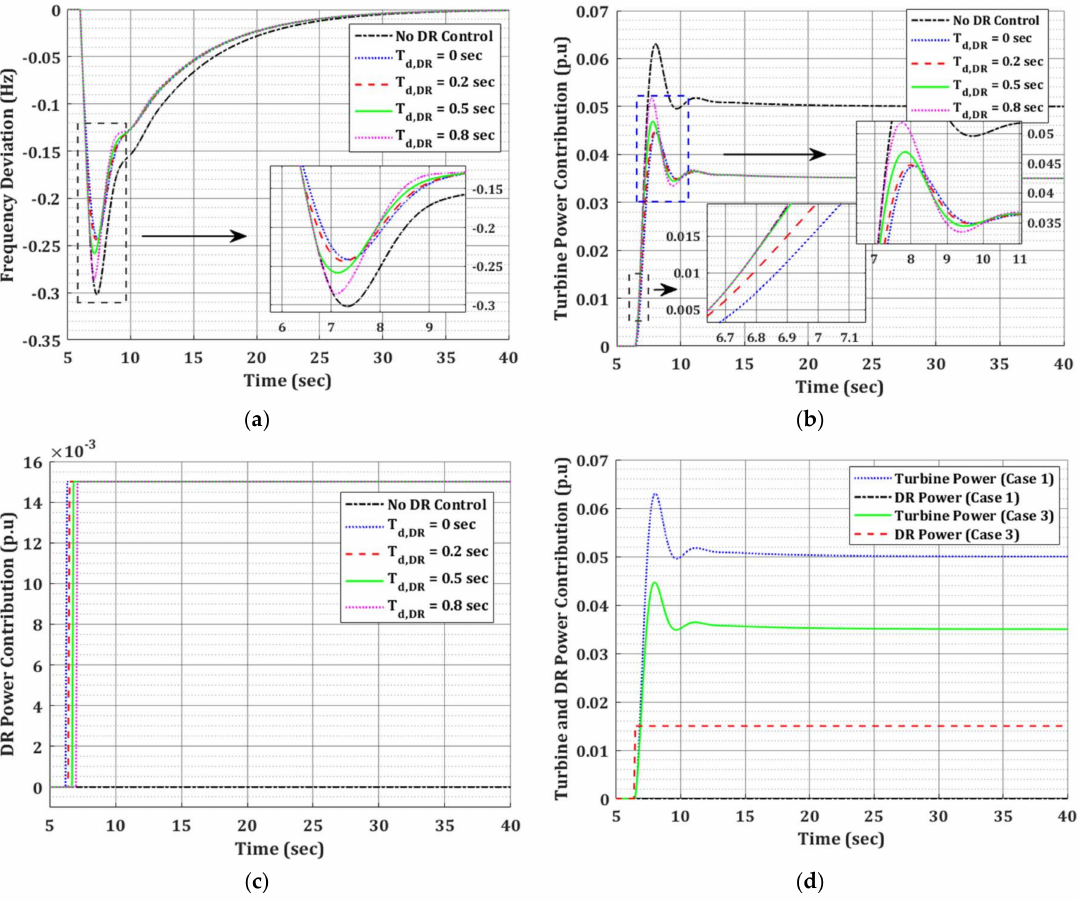
Figure 5. Effect of delay times ( T d , DR ) on various system parameters under load disturbance: ( a ) system frequency response; ( b ) change in turbine power (p.u); ( c ) change in DR power (p.u); and ( d ) change in turbine and DR power (p.u) for selected